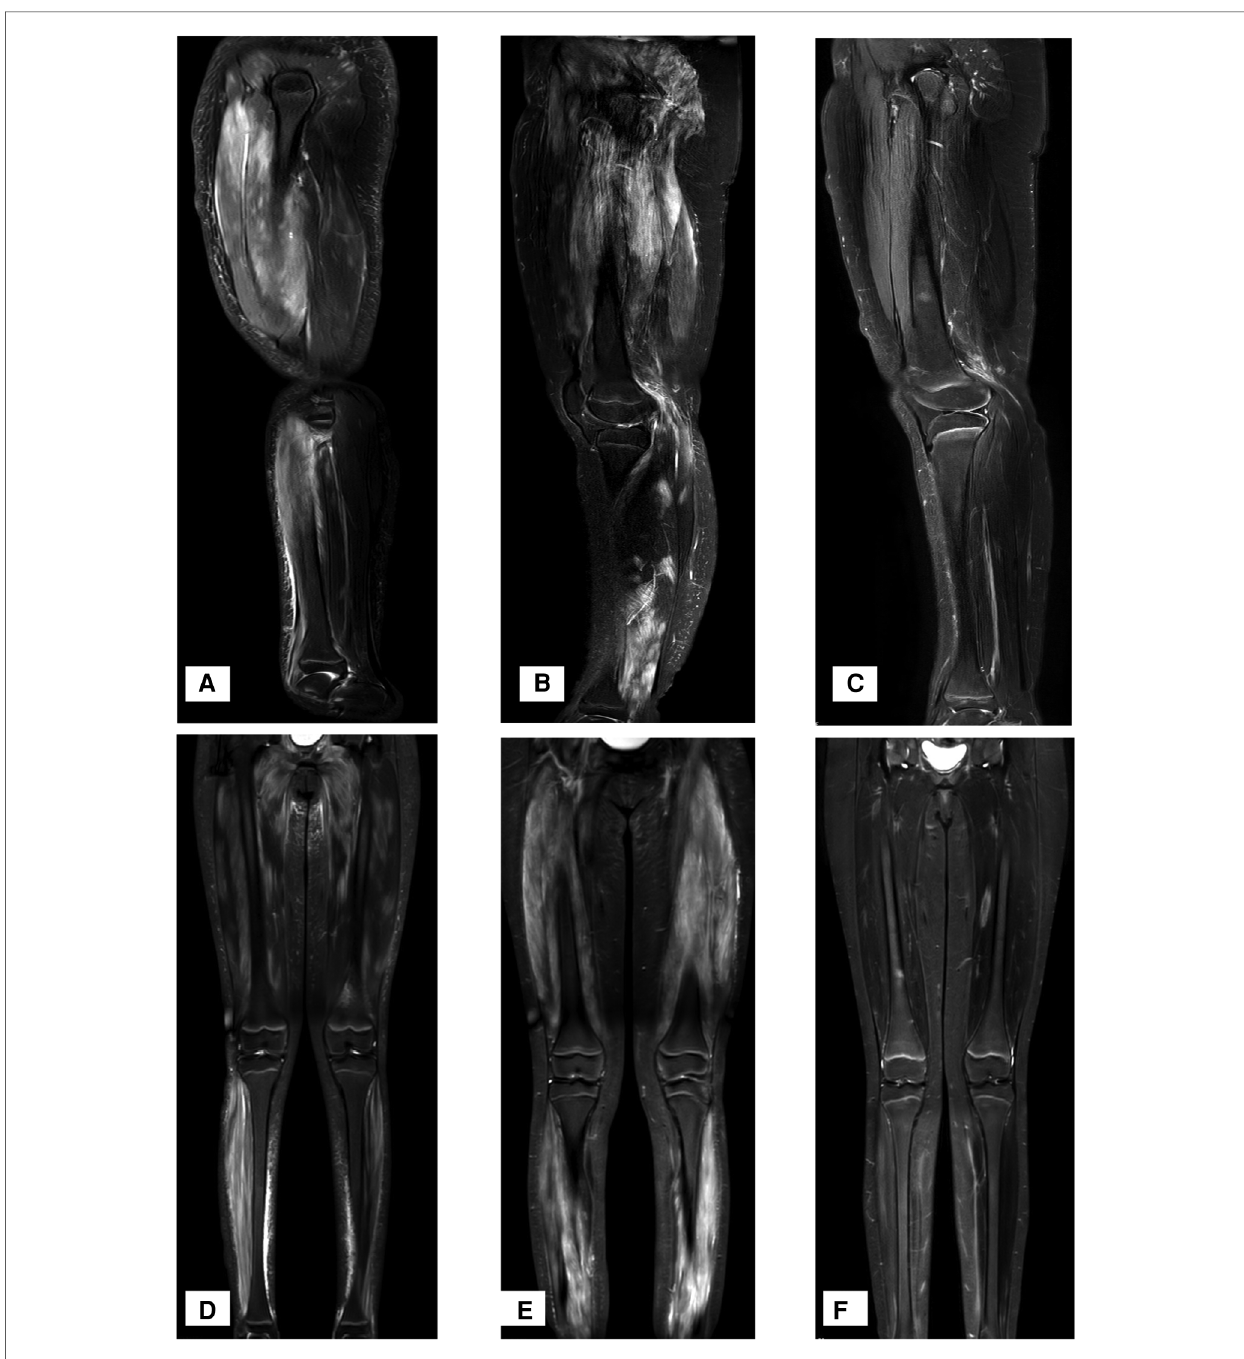
FIGURE 1 MRI T2W and stir-weighted images of the muscles at the time of onset. ( A,D ) T2W and Stir images at the time of onset, showing a high signal on T2- weighted and Stir images. ( B,E ) T2W and Stir images at the time of recurrence, showing extensive muscle damage. ( C,F ) T2W and Stir images one year after the application of